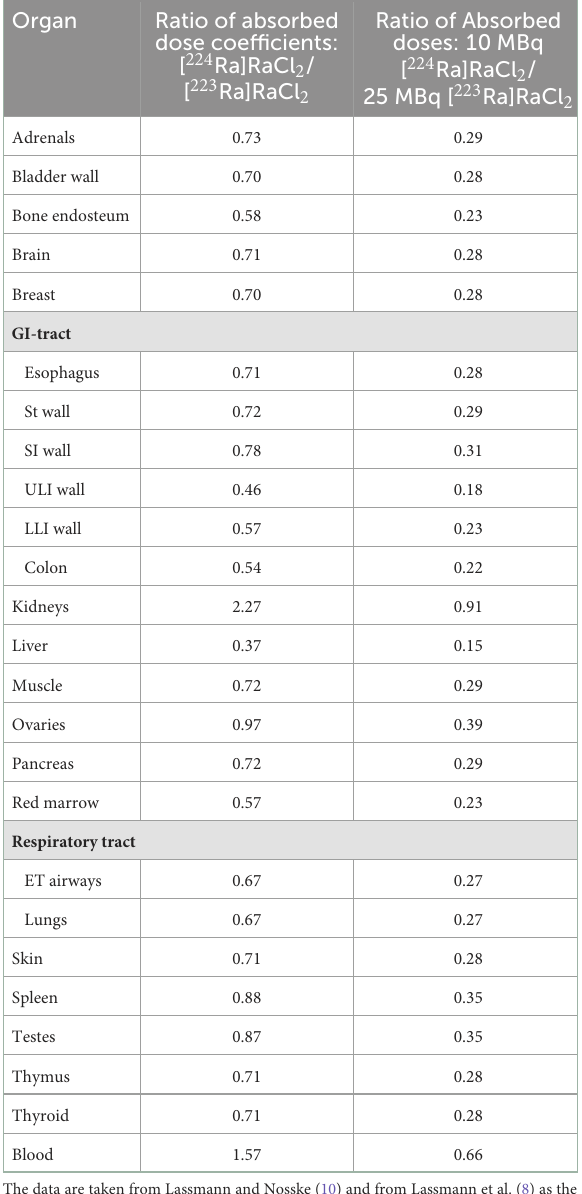
TABLE 1 Ratio of the absorbed organ dose coefficients (mGy/MBq) and the absorbed doses for typical administrations (10